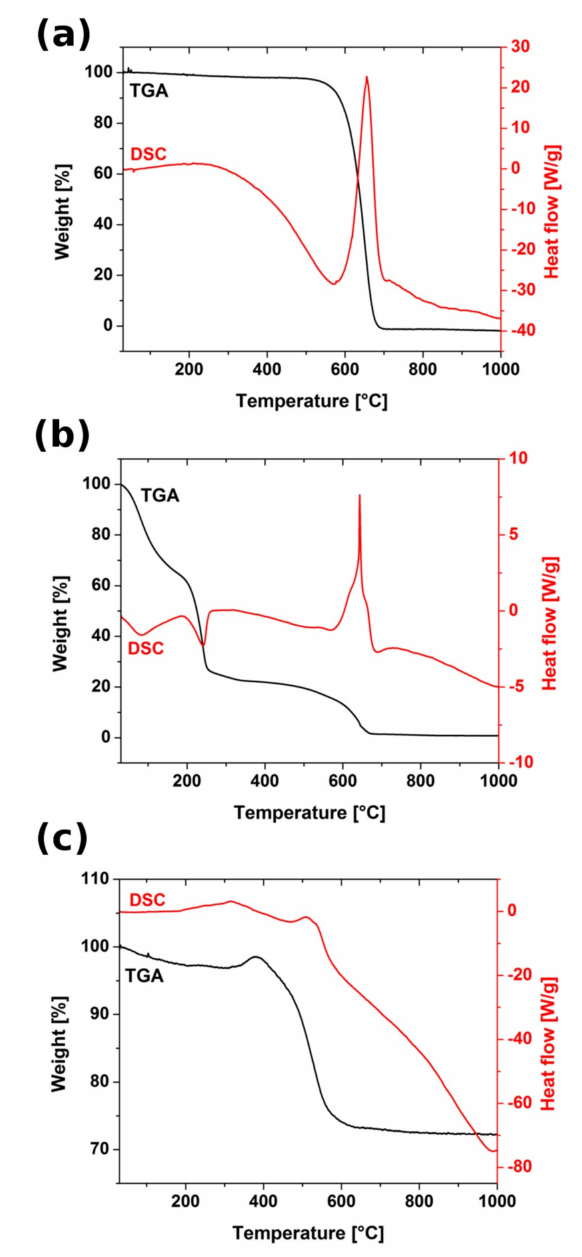
Figure 6. TGA (black) and DSC (red) curves recorded for ( a ) as-made CNT, ( b ) CNTOX and ( c ) Cu-CNT